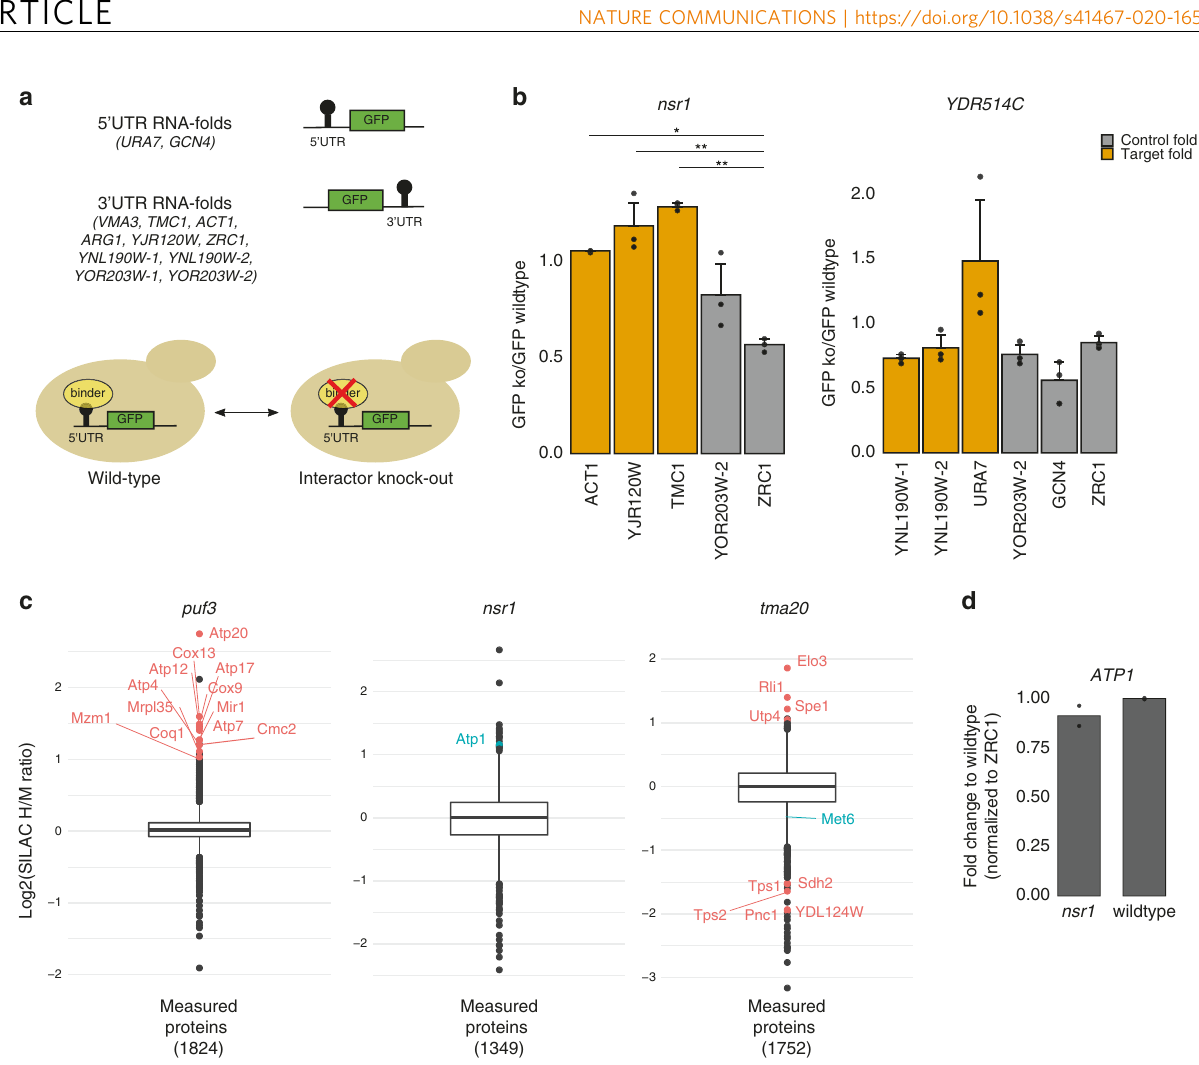
Fig. 4 Functional validation of mRNA – RBP interactions. a Schematics of the GFP reporter screen with either a 5 ′ UTR or 3 ′ UTR fused RNA fold. Expression is compared between the wild-type and knock-out yeast strain of the respective interactor. b Bar-plots display changes on the reporter expression levels when Nsr1 and YDR514C are bound to their respective folds (orange). Control experiments are RNA folds with no detected Nsr1 or YDR514C binding (gray). p -value * < 0.05 and ** < 0.01 based on analysis of variance (two-sided ANOVA and Tukey post-hoc test) in n = 3 biologically independent samples. ACT p -value = 0.017, YJR120W p -value = 0.005 and TMC1 p -value = 0.003. Data are presented in mean ±SD values. c Pulsed SILAC box plots showing log2(SILAC H/M ratio) values of all measured proteins for puf3 knock-out, nsr1 knock-out and tma20 knock-out strains compared to a wild-type strain (Supplementary Data 7). Boxes show median (center) and interquartile ranges (ends), lower whisker representing the smallest observation greater than or equal to 1.5 times the interquartile range and upper whisker representing the largest observation less than or equal to 1.5 times the interquartile range. d qRT-PCR expression levels of ATP1 mRNA in a nsr1 knock-out strain compared to the wild-type strain. Data are presented as mean values in n = 2 technical replicates.